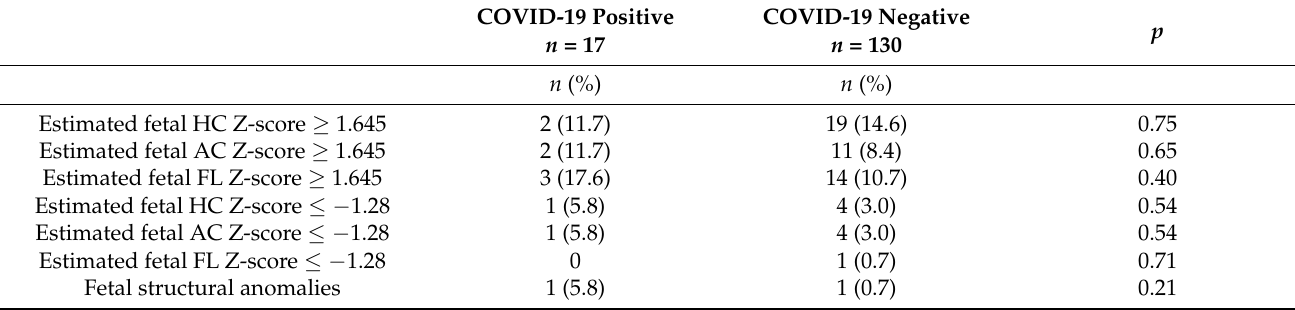
Table 3. Second-trimester fetal anatomy scan findings in COVID-19-positive and -negative